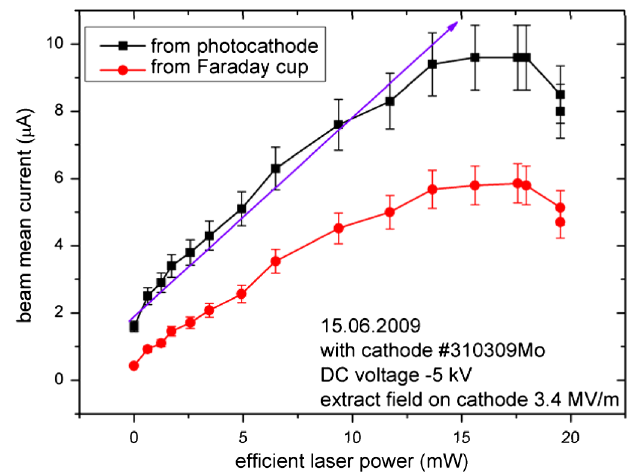
FIG. 6. (Color) Beam current saturation in the SRF gun. The repetition rate of the micropulses was 125 kHz so that the maximum beam current of about 6 (cid:1) A belongs to a bunch charge of 50 pC. The laser spot on the cathode was (cid:1)2 mm